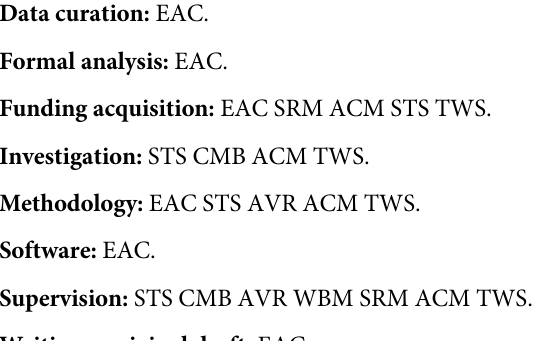
S6 Table. Adjusted RRs and 95% CI stratified by aspirator type. Adjusted risk ratios (RR) and 95% confidence intervals (CI) for cross-sectional adult stage measures of Ae . aegypti com- paring data collected during periods in which the aspirator was changed in 2009: 1999–2008, the CDC backpack aspirator and 2010, the Prokopack